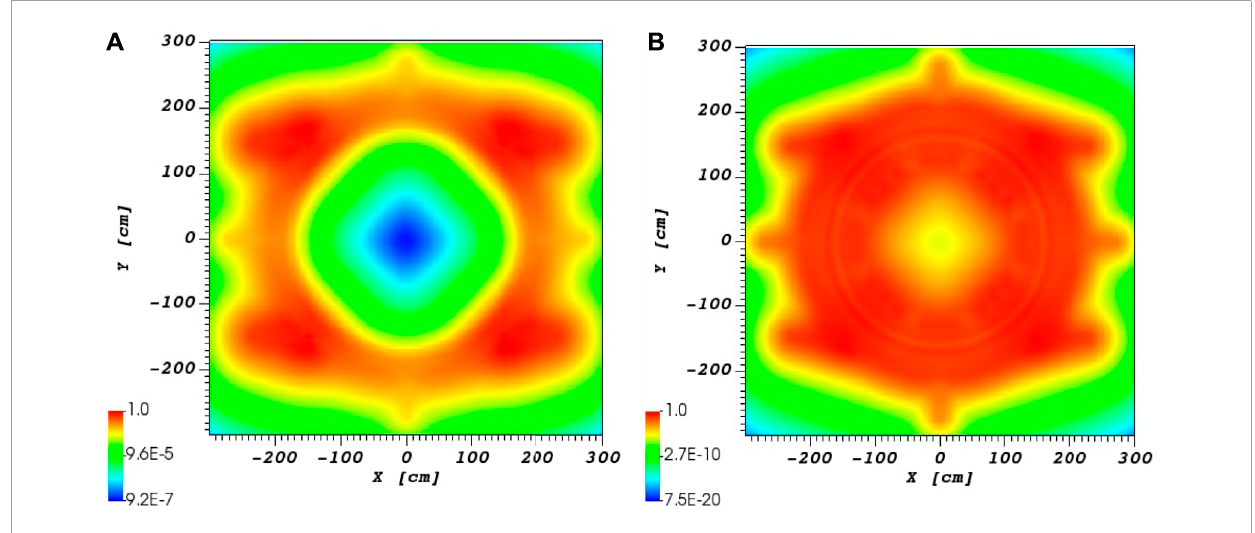
FIGURE 6 Results of the adjoint calculation using the ADVANTG code. Values are presented in colors in logarithmic scale, ranging from low values in blue to high values in red. Presented is axial slice approximately in the middle of active fuel height, normalized to the maximum value. (A) Adjoint neutron flux. (B) Contributon field distribution.